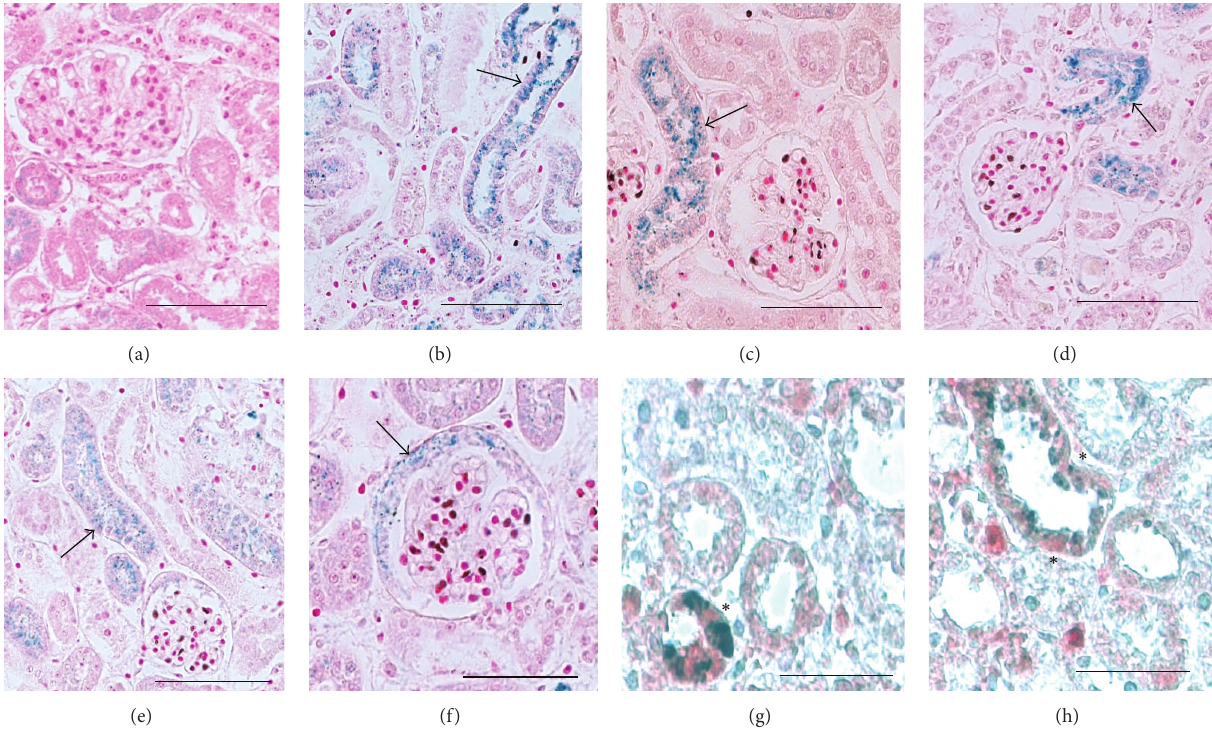
Figure 7: 𝛽 -catenin/TCF pathway reporter activity in exogenous CD 24+ cells during integration into the glycerol-damaged adult renal tubule. (a–h) CD 24+ cells (0.5 million) were isolated by FACS from embryonic E15 mice bearing the 𝛽 -catenin/TCF reporter and infused into CD1 wild-type adult mice 3 days after i.m. administration of glycerol 8 𝜇 L/g or PBS (control). Kidney sections were stained with X-Gal to identify 𝛽 -catenin/TCF reporter activity (blue) after an additional 3 days. (a) Minimal 𝛽 -catenin/TCF reporter activity is seen after infusion of CD cells into control mice. (b-c) Strong 𝛽 -catenin/TCF reporter activity (arrow) is seen in exogenous cells integrated into glycerol-damaged renal tubules. (d-e) 𝛽 -catenin/TCF reporter activity (arrow) is seen in exogenous cells integrated into the S1 segment of glycerol-damaged proximal tubules. (f) 𝛽 -catenin/TCF reporter activity (arrow) is seen in exogenous cells integrated into the urinary pole of Bowman’s capsule. (g-h) Exogenous CD 24+ cells integrated into glycerol-damaged renal tubules exhibit both 𝛽 -catenin/TCF reporter activity and strong staining for the marker of cell proliferation, PCNA (red) (asterisk). Scale bars: 50 𝜇 m.